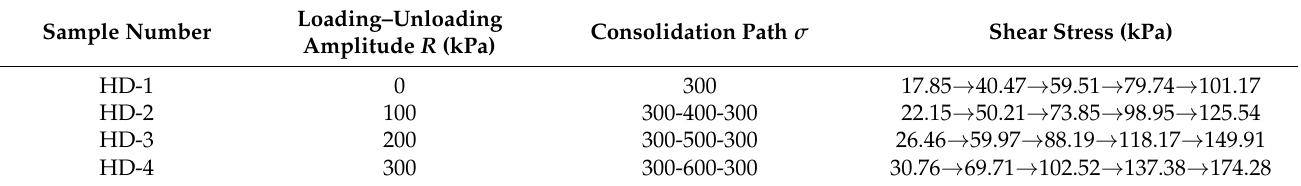
Table 1. Applied shear stresses